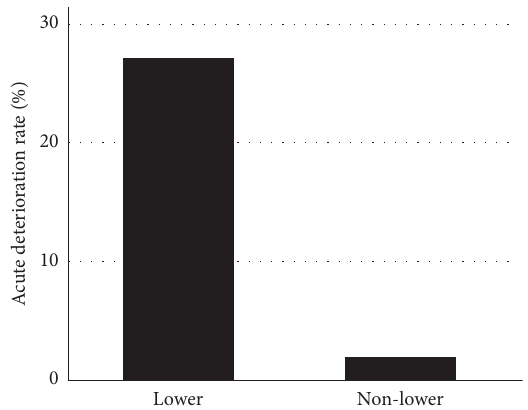
Figure 3: Comparison of the acute deterioration rate between patients with lower dominance and nonlower dominance.